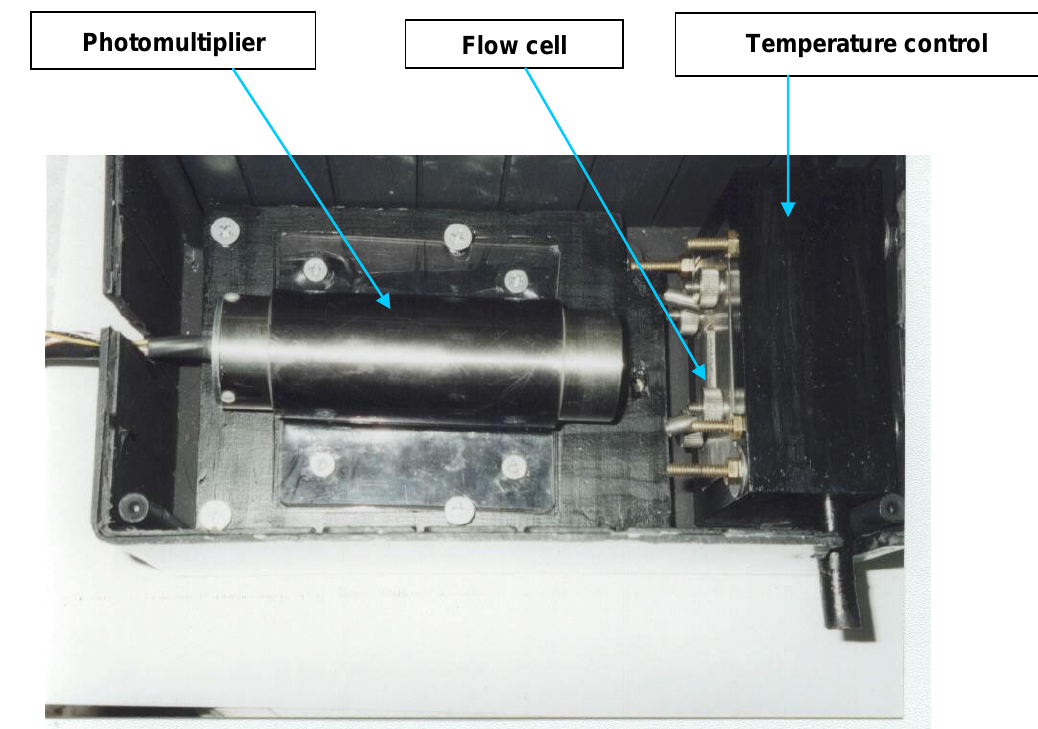
Figure 2. Detector unit incorporating photomultiplier tube, flow cell and temperature control of the flow cell.